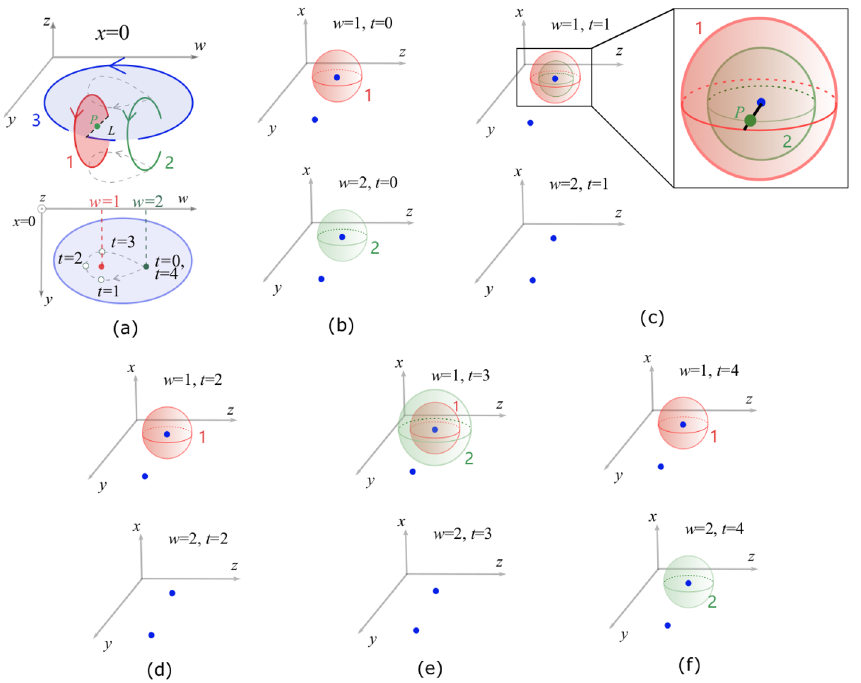
Figure 7 . Loop-membrane-membrane braiding described by BAdA term viewed in 3 D space. (a) Viewed in ywz -space with x = 0 , the two membranes ( 1 and 2 ) appears as two loops that are linked with the loop excitation (loop 3 , blue) respectively. Loop 3 and membrane 1 are assumed to be static in space. This loop-membrane-membrane braiding looks like a 3 -loop braiding in ywz -space with x = 0 while this 3 -loop braiding can be further viewed as a braiding of two anyons on the Seifert surface of loop 3 . The Ω 3 in eq. (2.47) is projected to the 2 D Seifert surface of loop 3 . Ξ 1